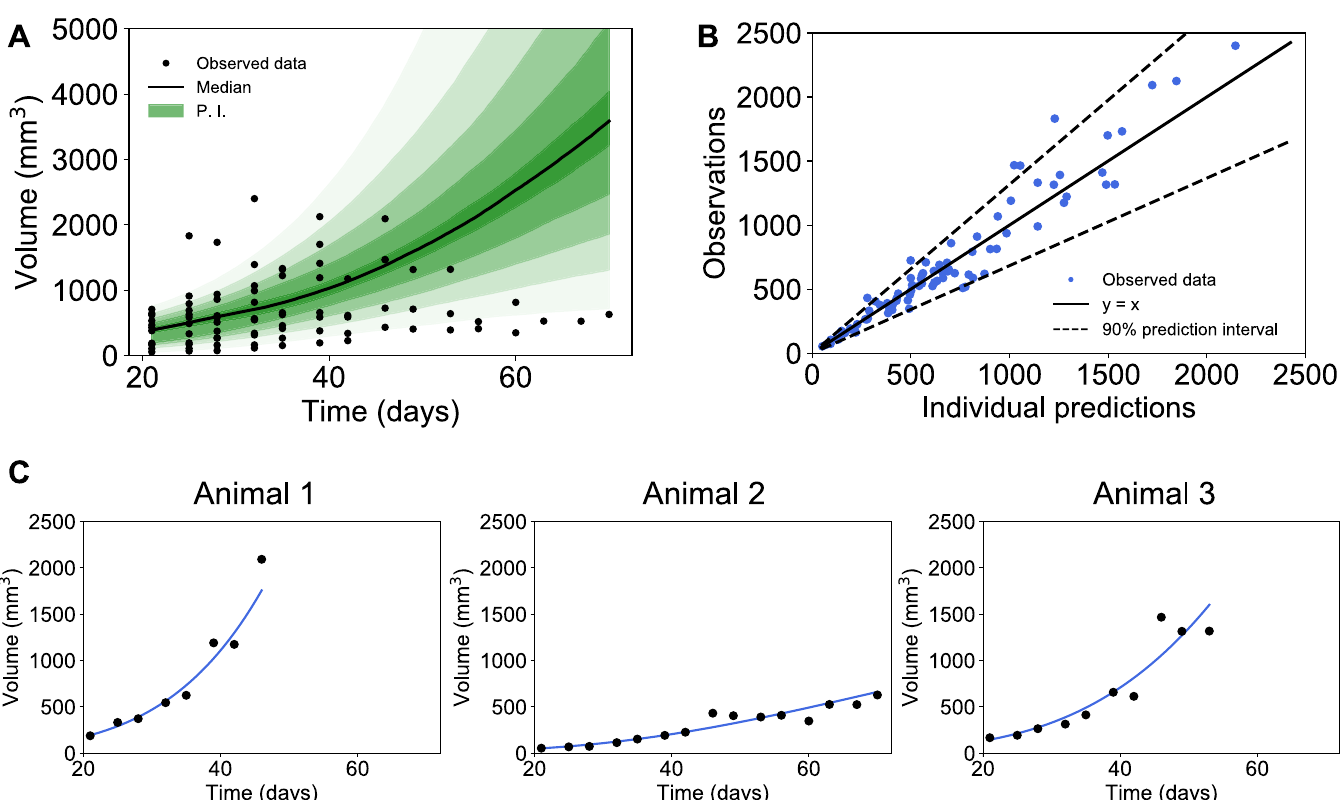
Fig 4. Population analysis of the Gompertz model fitted against data obtained with formula 2. (A) Prediction distribution of the Gompertz model fitted against the data. P.I. = prediction interval. (B) Observations vs individual predictions (C) Three representative examples of individual fits chosen randomly.